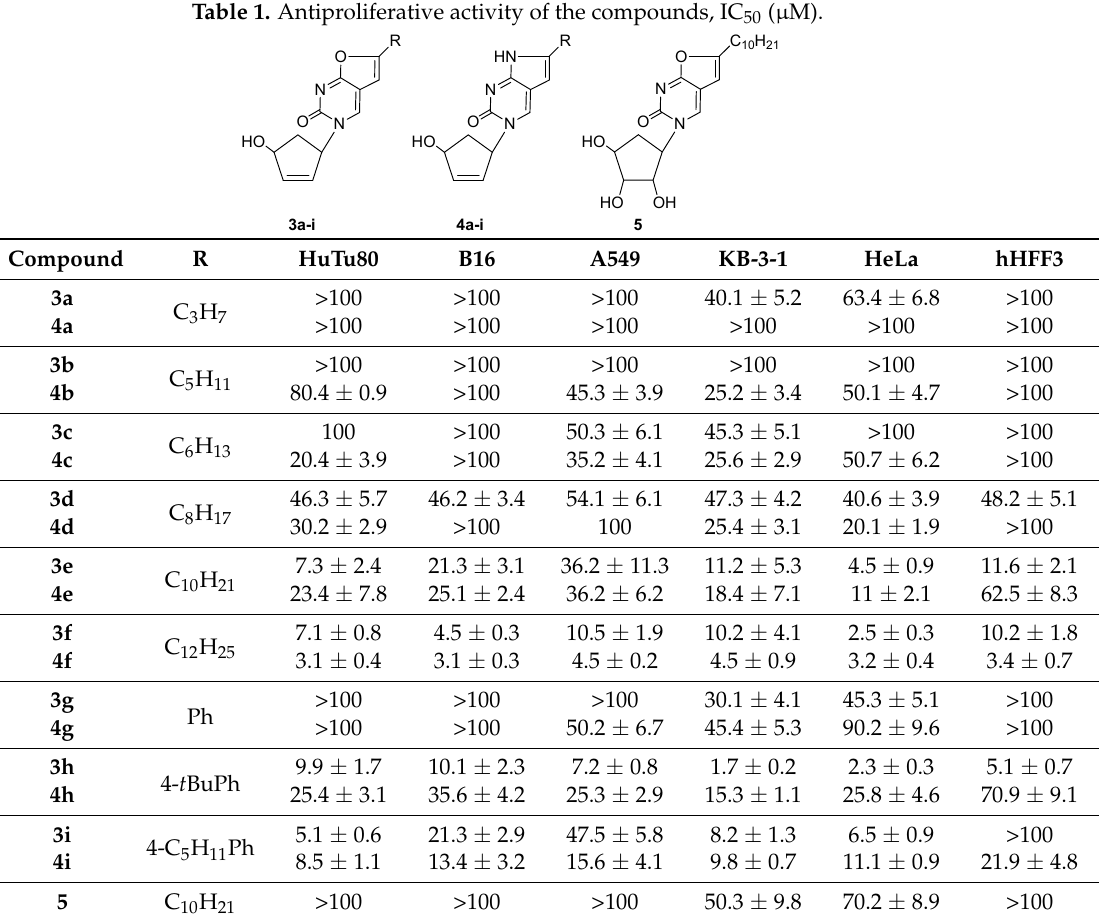
Table 1. Antiproliferative activity of the compounds, IC 50 (µM).